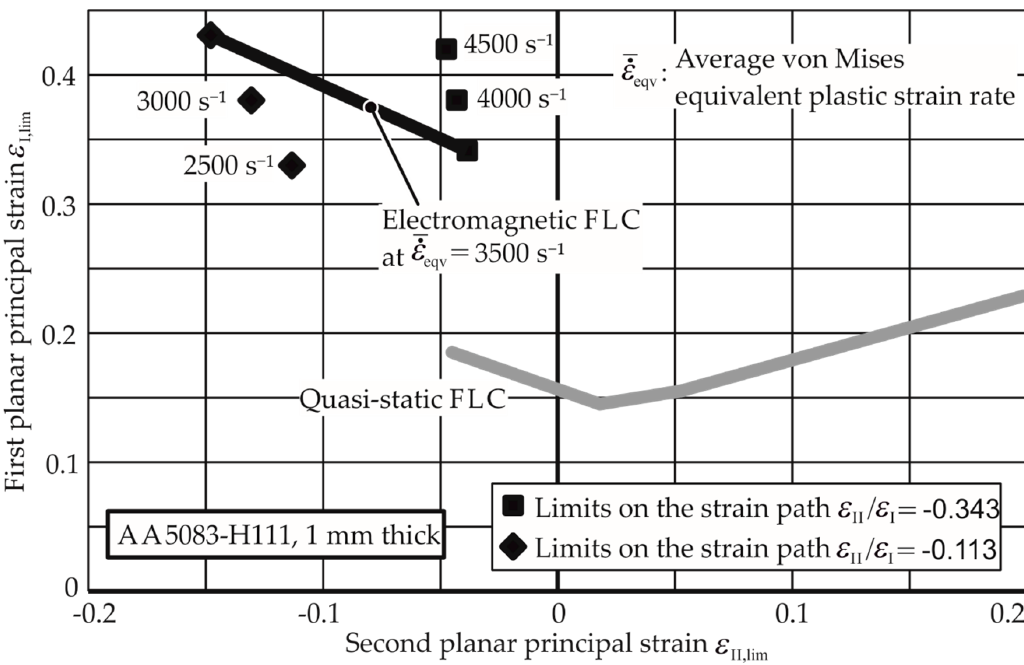
Figure 17. Electromagnetic forming limit curves (FLC) of AW-5083-H111 at different strain rates. The quasi-static FLC is given for comparison.